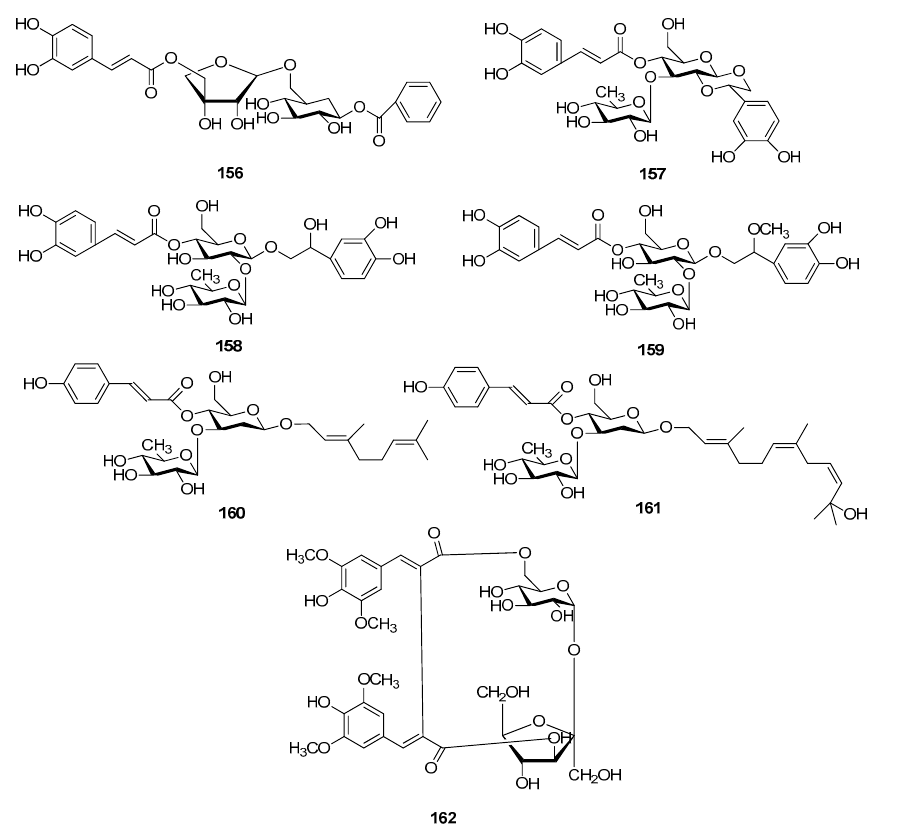
Figure 16. Structures of compounds 156 – 162 .